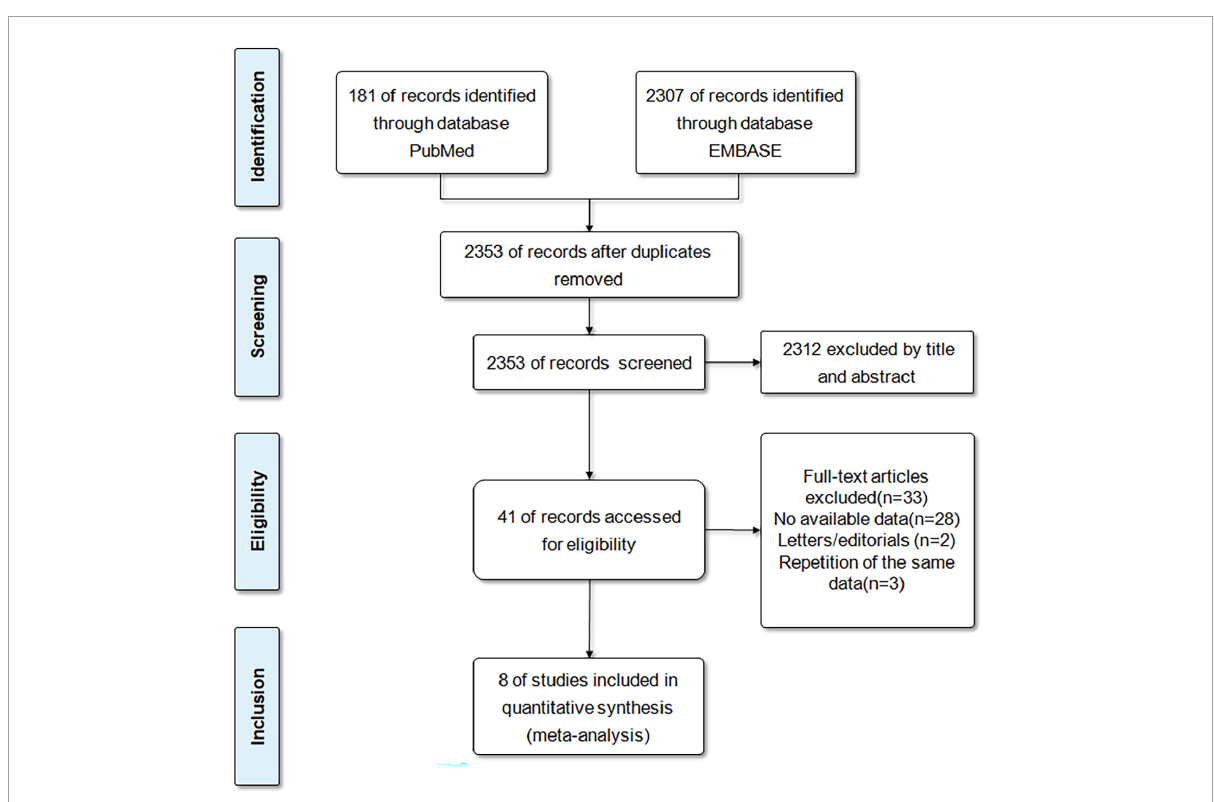
FIGURE1 The flow diagram of literature review and study